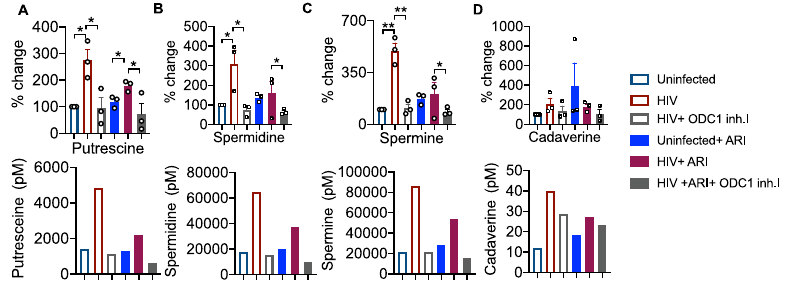
Fig. 6 | HIV-1 infection associated polyamine increase is dependent on ODC-1 activity. HTOC CD4 + T cells were TCR activated and infected with HIV. ARI and ODC-1 inhibitor I were added as indicated, 36h post-infection. Quanti fi cation of putrescine ( A ), spermidine ( B ), spermine ( C ), and cadaverine ( D ) relative to the uninfected controls are shown (top). Thermospermine was not detected. Means withstandarddeviationerrorbarsfromthreeindependentexperimentsareshown.